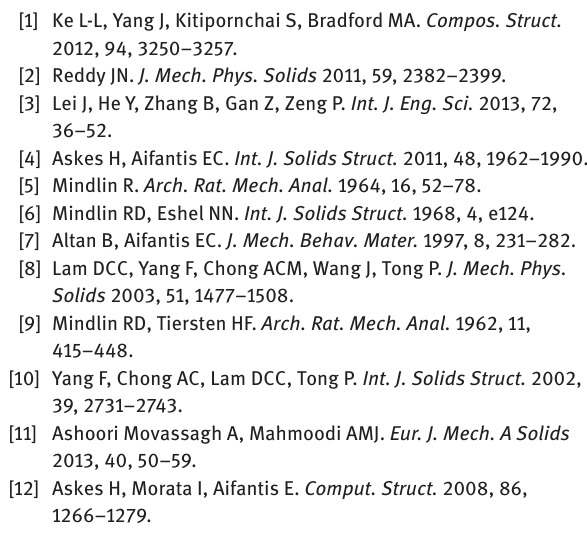
Table 4: Percentage of computational error due to lack of consideration of the precise location of the neutral axis in FG nanobeams. ) K = 0, b = h = 10, L = 50 h, P = 0 [ P = 0.95 Pcr| n ( z 0